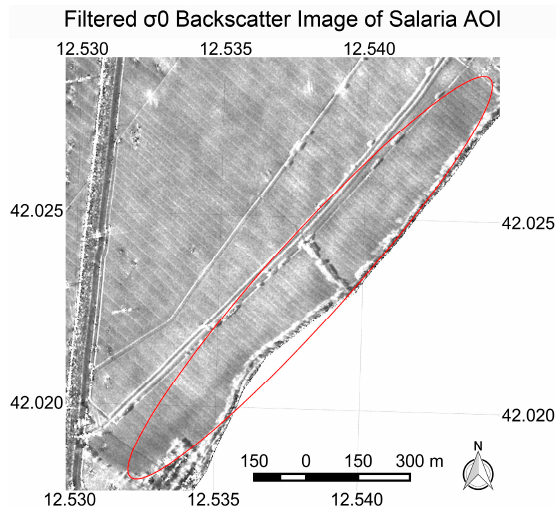
Figure 46. Image of filtered σ 0 backscatter over the Salaria AOI acquired on 7 April 2013. Red ellipse shows location of the residue of the ancient Via Salaria. COSMO SkyMed data provided by the Italian Space Agency.